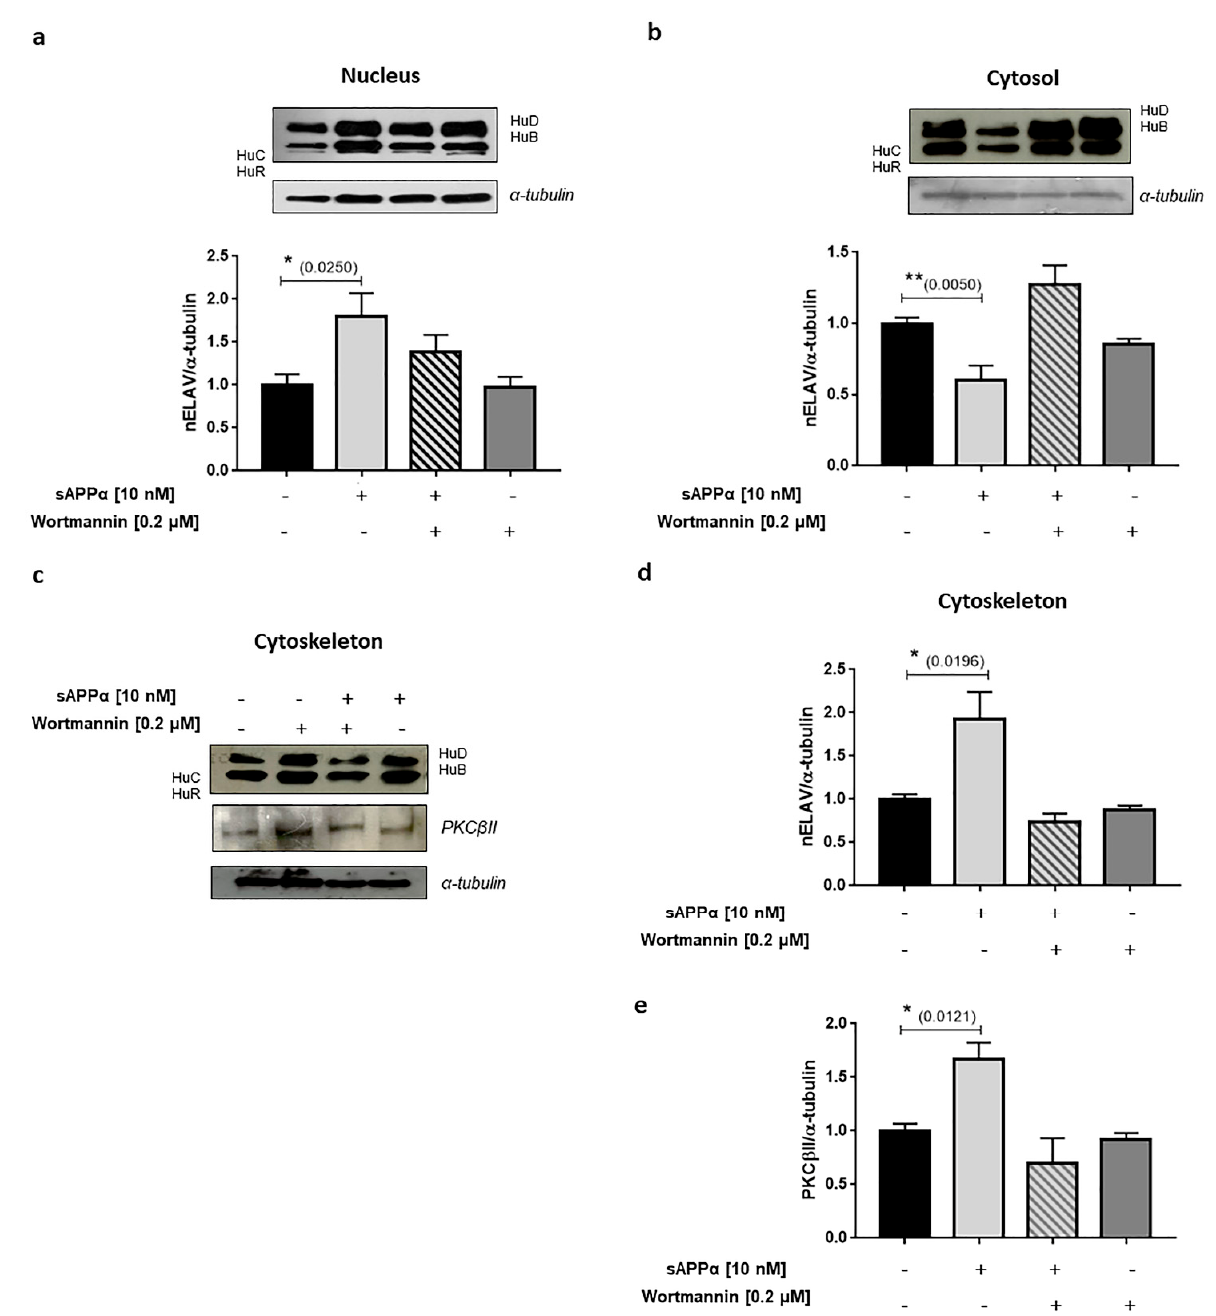
Figure 6. Evaluation of the PKC β II/nELAV/VEGF pathway in sAPP α -mediated effects on VEGF. ( a – e ) SH-SY5Y cells were treated with 10 nM sAPP α alone or in combination with 0.2 µ M Wortmannin (an irreversible PI3K inhibitor). Subcellular fractionation was performed as previously described [141]. The image is a representative Western blot. nELAV protein levels were analysed in the nucleus ( a ), cytosol ( b ) and cytoskeleton ( c , d ) fractions. PKC β II protein levels were analysed in the cytoskeleton fraction ( c , e ). Protein levels were normalised to α -tubulin expression. Results are expressed as mean ± SEM, n = 3 independent experiments. Statistical analysis was performed with one-way ANOVA followed by Dunnett’s multiple comparison test with * p < 0.05 and ** p < 0.01 vs. control (untreated cells). Statistical significance is detailed in the respective figure panel.